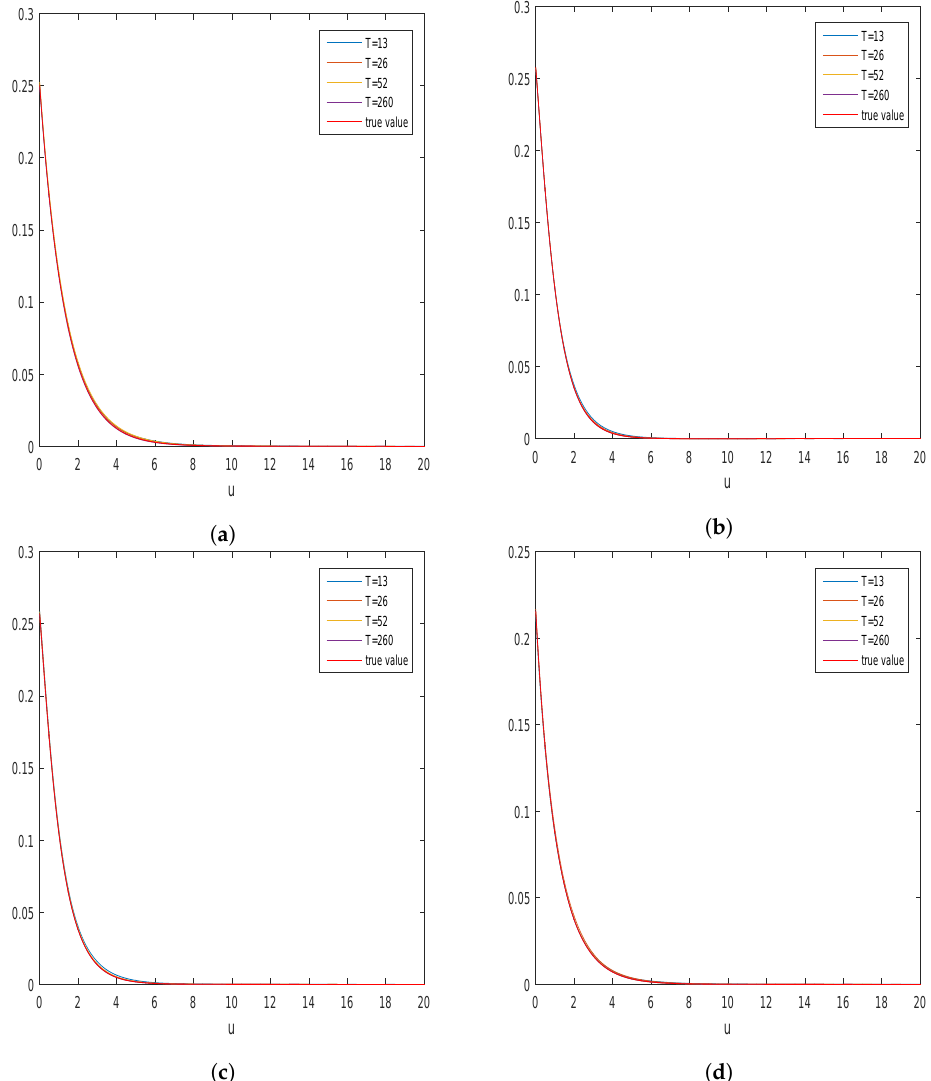
Figure 2. Estimation of the Laplace transform of ruin time for different claim sizes. Mean curves: ( a ) exponential claim sizes; ( b ) Erlang claim sizes; ( c ) combined-exponential claim sizes; and ( d ) mixed-exponential claim sizes. Table 1. IMSE of (cid:98) Φ K , a